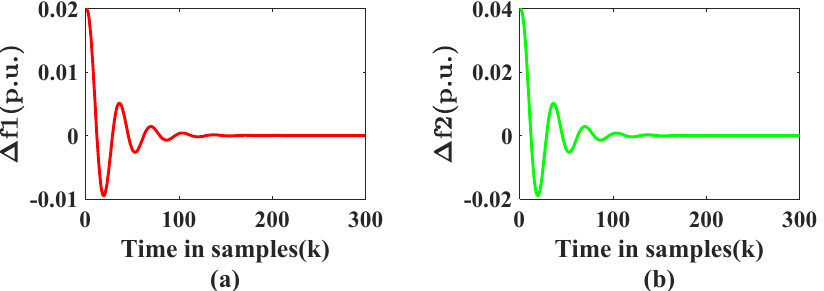
Figure 5. Dynamic response curve of the load frequency deviation under the PSO-MPC strategy with wind turbines. ( a ) Load frequency deviation under Δ P L 1 ; ( b ) Load frequency deviation under Δ P L 2 .